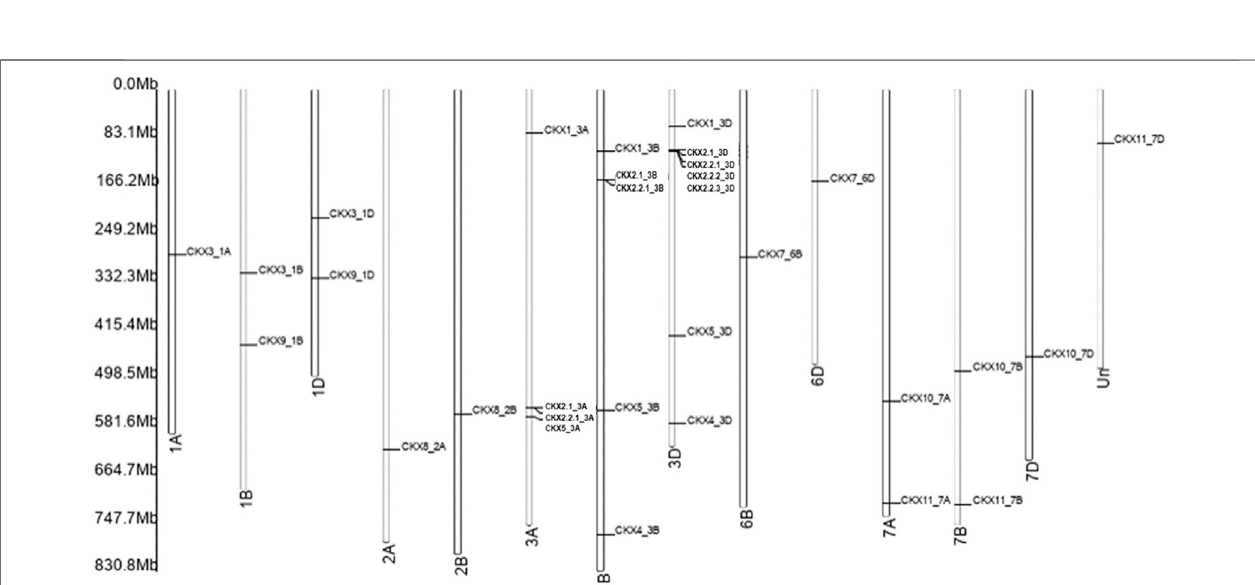
Frontiers in Genetics |